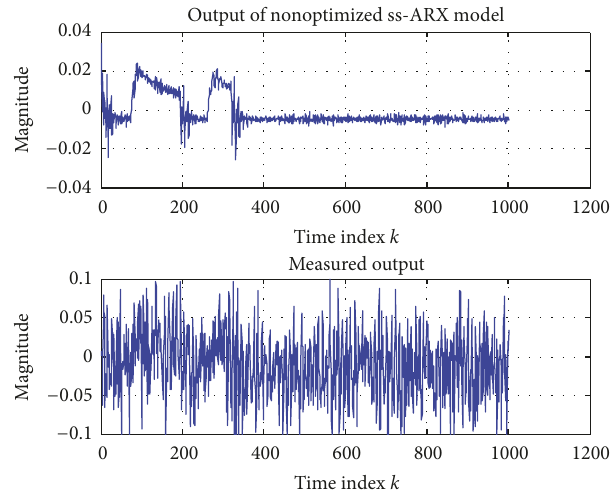
Figure 11: Simulated and measured output using no optimized ARX (balanced realization) model at flow coefficient 0.51.